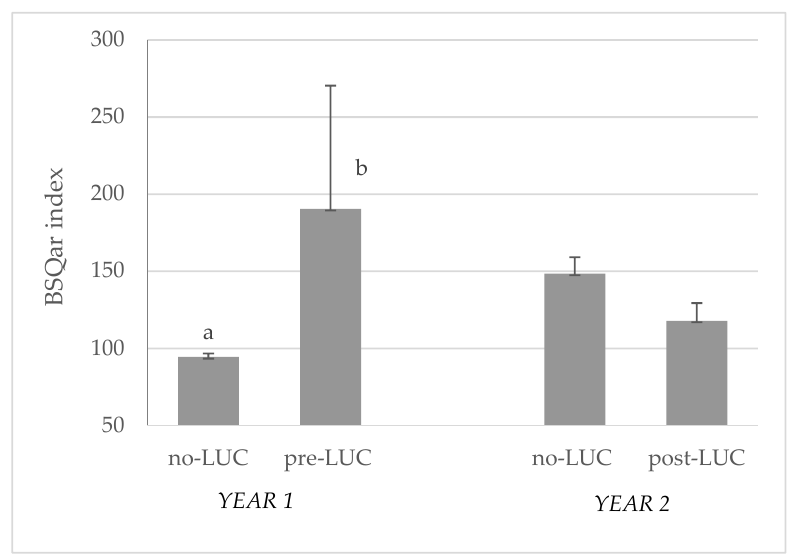
Figure 3. Biological soil quality by BSQar index in the experimental areas. Data were expressed as mean ± SD and 95% confidence interval by different letters. Significance was evaluated within the year (Mann–Whitney test, p < 0.02).